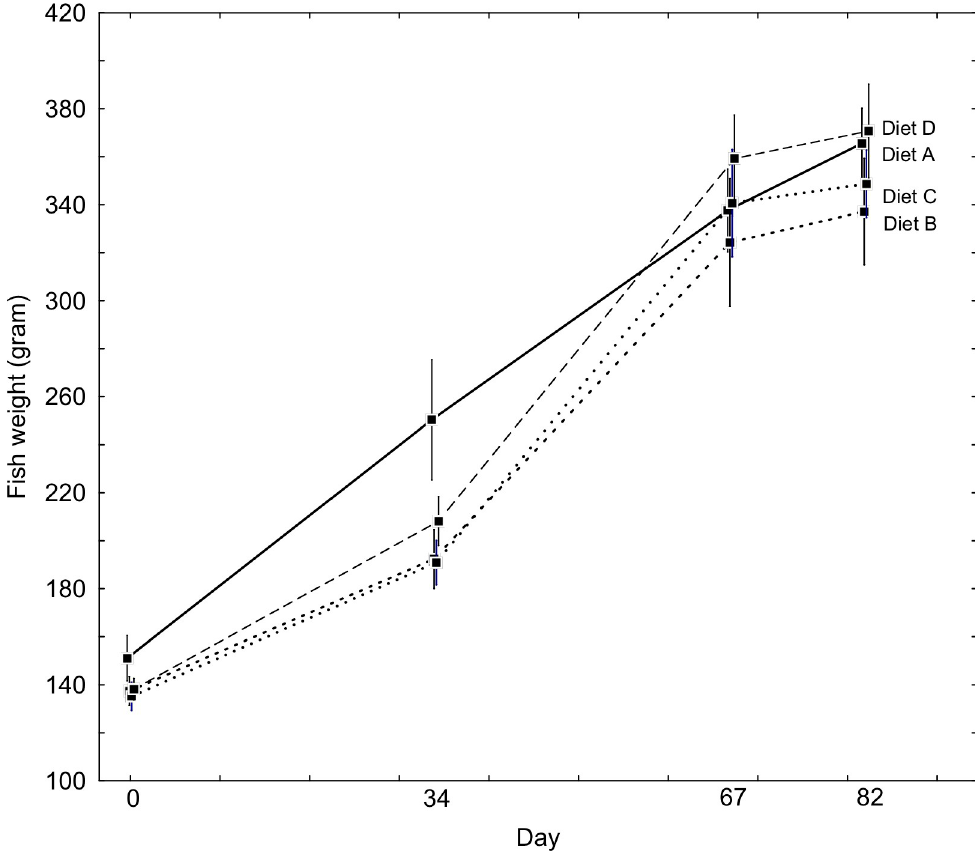
Fig 1. Weight vs. time for salmon fed the different (A–D)